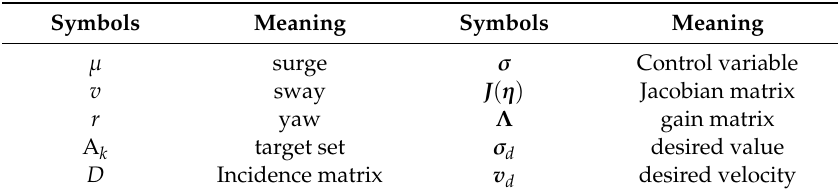
Table A1. Table of